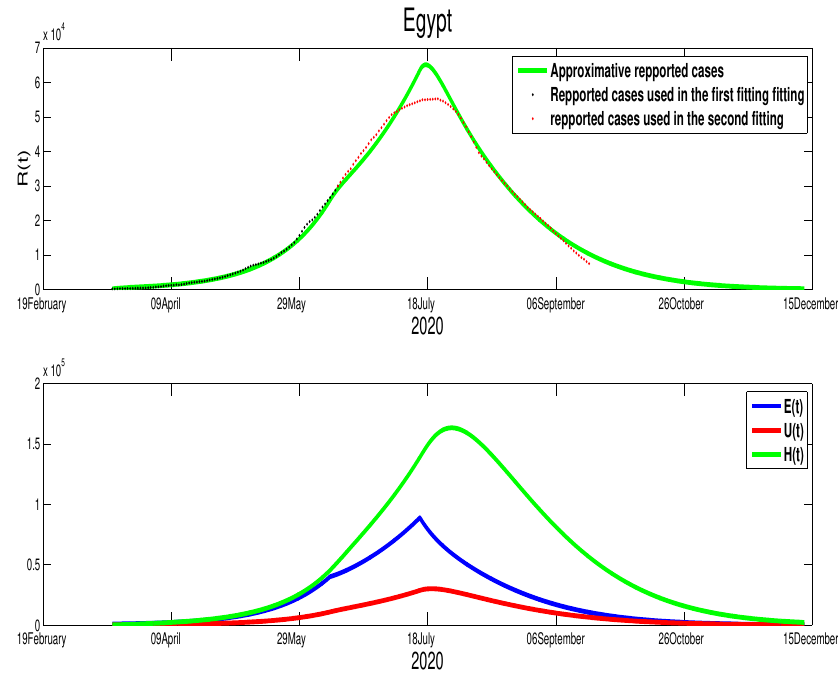
Figure 15. The evolution of the infection cases in Egypt until the end of